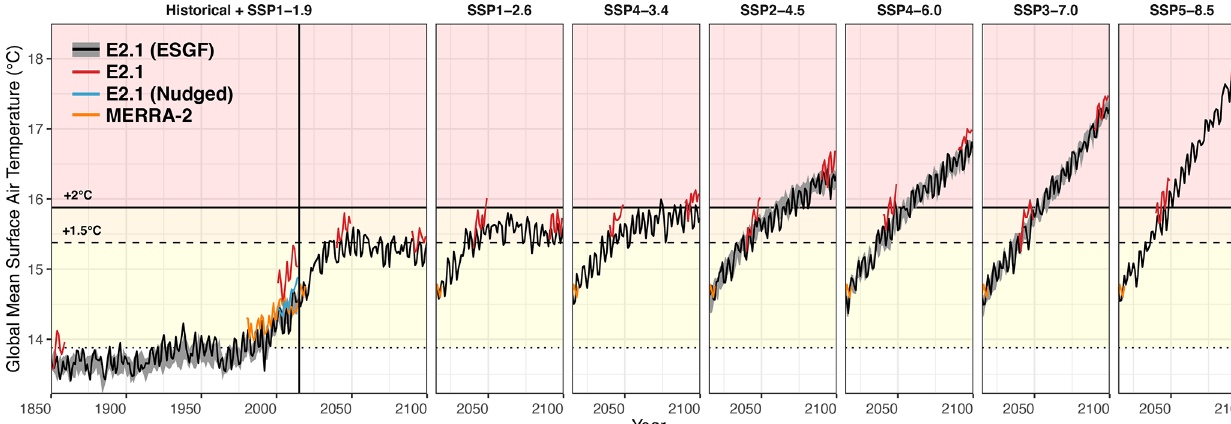
Figure 2. Temporal evolution of global mean surface temperature in ◦ C. Each panel from left to right shows the seven future scenarios arranged by increasing radiative forcing. The black line shows variable tas from the E2.1 ensemble member (r1i1p1f2) that our simulations are based upon obtained from the ESGF repository. The gray shading represents the annual mean and 2 σ spread of all E2.1 ensemble members archived on ESGF. The red line shows the value from our reruns of r1i1p1f2 to generate the GCAP 2.0 meteorology. The blue line shows the same but with winds nudged to the MERRA-2 reanalysis. The orange line shows the global mean surface temperature from the MERRA-2 reanalysis. The horizontal lines show the global pre-industrial climatological mean in our simulations (dotted black) and 1.5 ◦ C (dashed black) and 2.0 ◦ C (solid black) increases on top of the pre-industrial